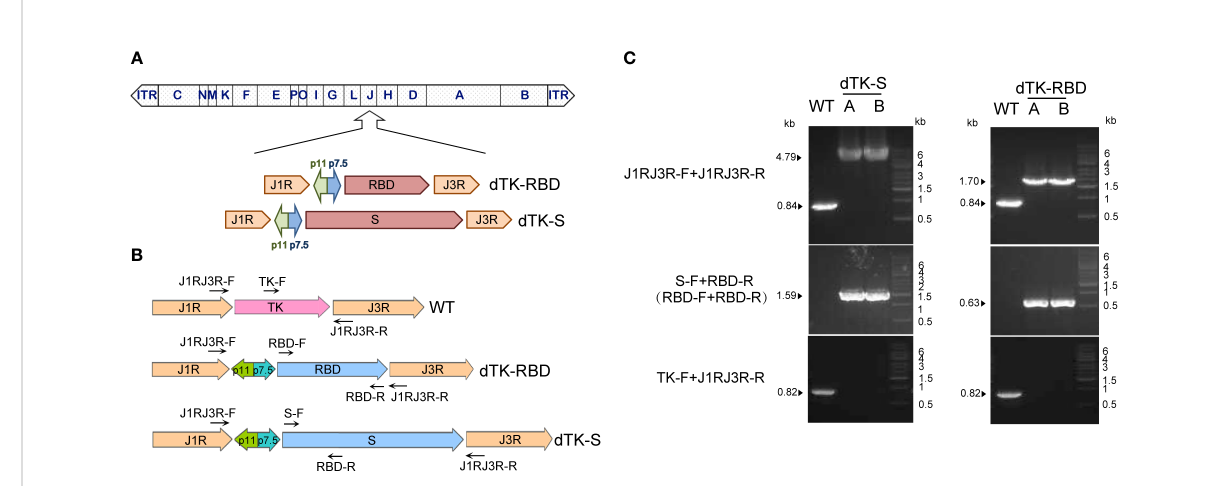
FIGURE 1 Construction of VACV recombinants expressing SARS-CoV-2 spike protein or RBD. (A) Schematic representation of VACV dTK-S and dTK-RBD. The SARS-CoV-2 S (with last 19aa deleted, dTK-S) and RBD sequences (319aa – 529aa, dTK-RBD) were inserted into thymidine kinase (TK) locus of VACV Tiantan strain under the control of the early/late promoter p7.5 by homologous recombination. (B) Schematic representation of primers used for plaque puri fi cation and PCR veri fi cation. (C) PCR analysis of recombinant viruses con fi rmed the substitution of spike or RBD for the TK region. VACV, vaccinia virus; SARS-CoV-2, severe acute respiratory syndrome coronavirus 2; RBD, receptor-binding domain; dTK-S, vaccinia virus-expressing spike protein; dTK-RBD, vaccinia virus-expressing receptor-binding domain; TK, thymidine